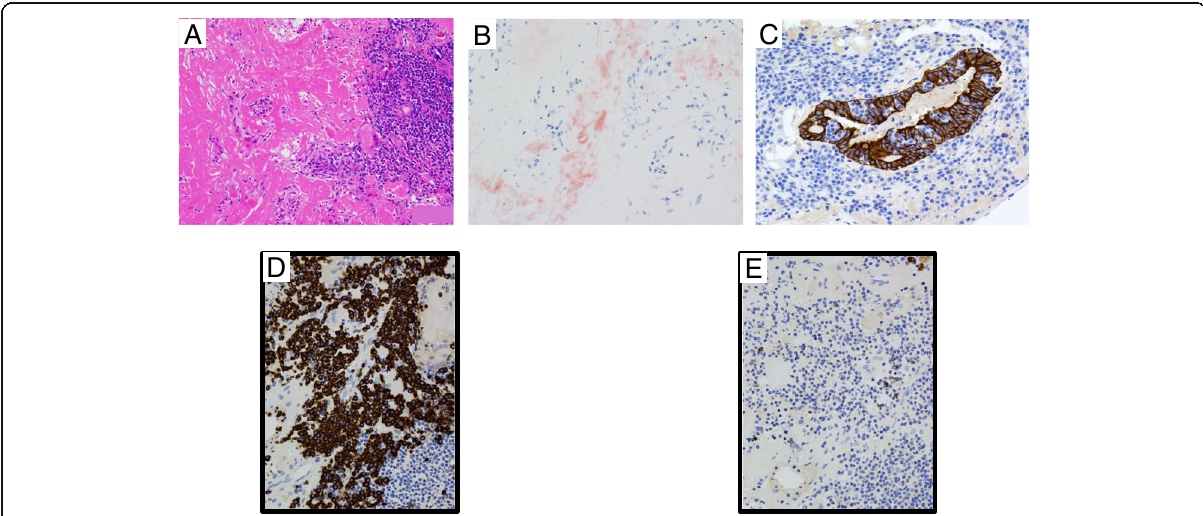
Fig. 2 a Eosinophilic deposition with lymphoplasmacytic infiltration was noted. b The eosinophilic deposition stained positive with Congo red. c Immunostaining for AE1/AE3 and CD20 revealed extensive infiltration of B cells to the bronchial epithelial cells (lymphoepithelial lesion). d , e B cells with monoclonal proliferation predominantly had a κ chain by in situ hybridization ( κ chain: λ chain ratio,